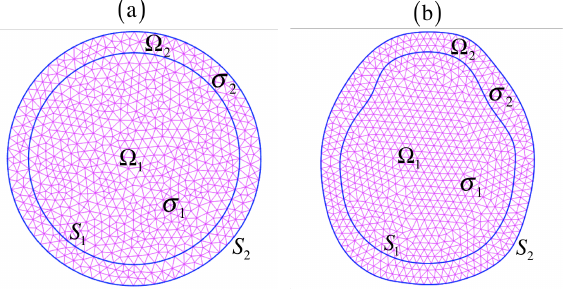
Ω 2 . Source g is defined on interface S 1 . ( a ) Circular ∪